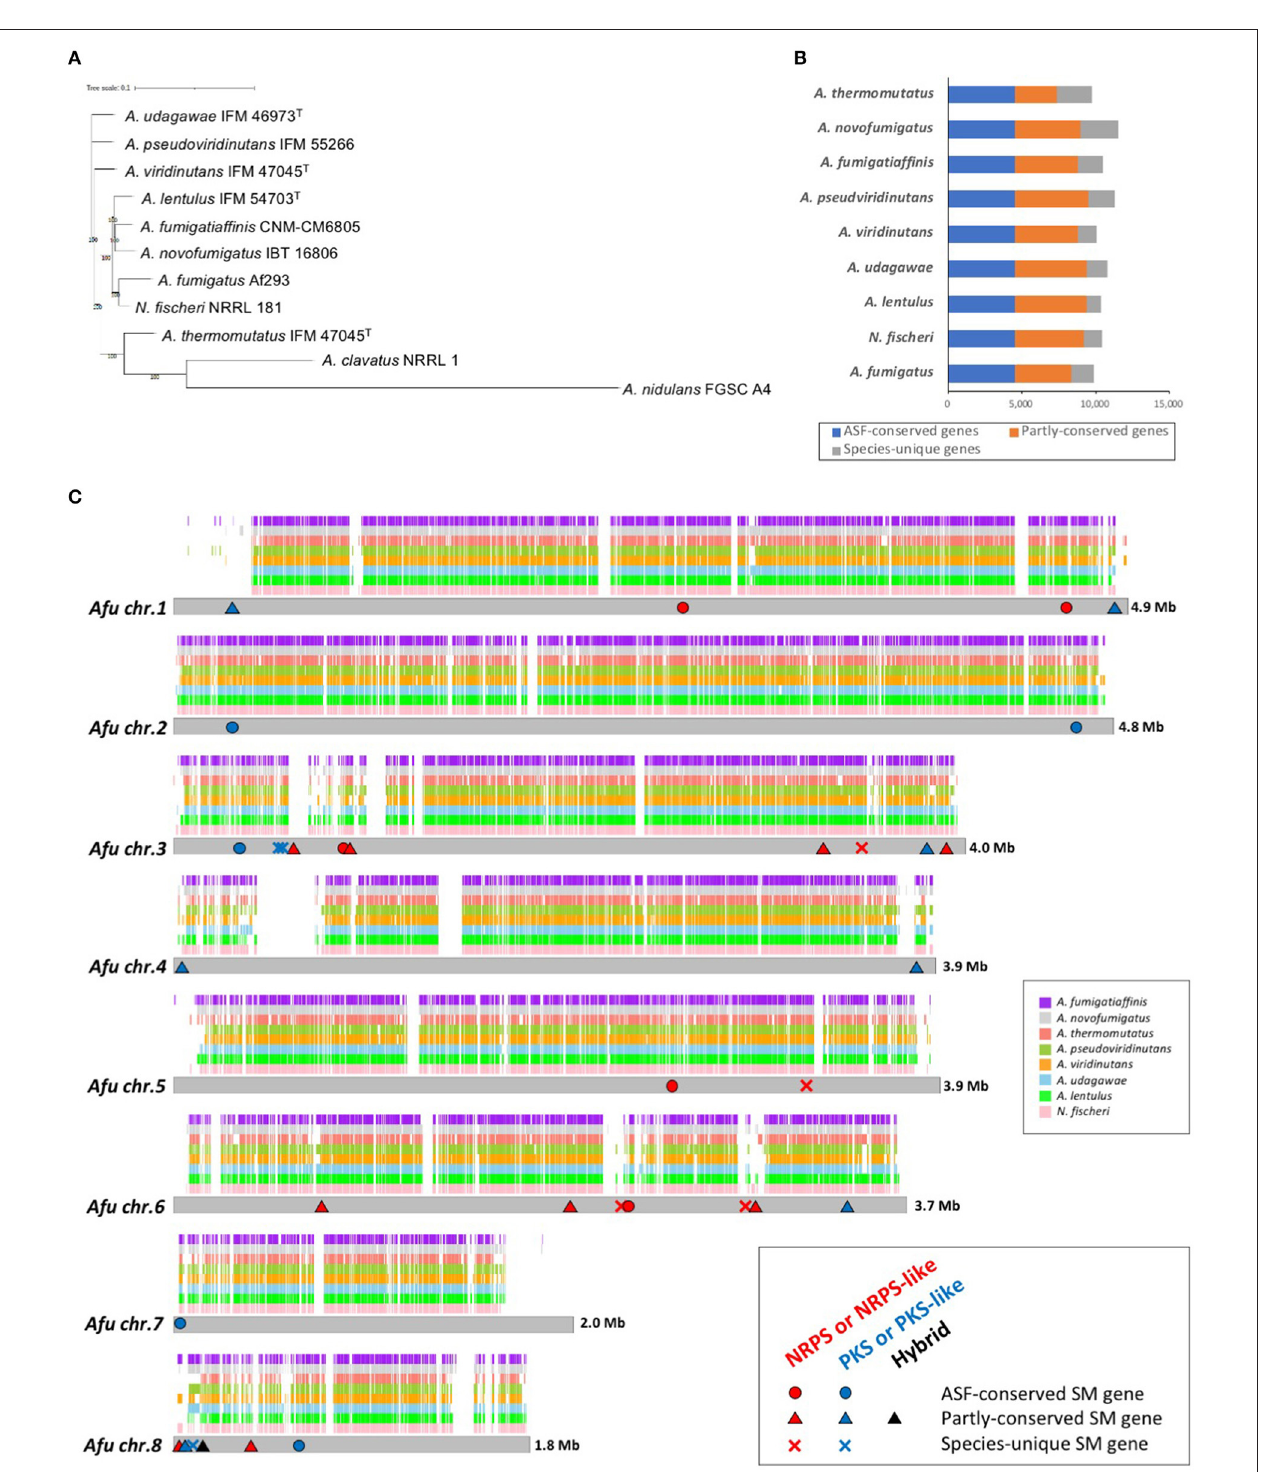
FIGURE 1 | Genome characteristics of Aspergillus section Fumigati strains. (A) Phylogenetic tree of the nine species of Aspergillus section Fumigati used here in addition to A. clavatus and A. nidulans as the outgroup. The tree was constructed using iTOL. (B) The numbers of genes that are conserved across the section (“ASF-conserved genes”), partly conserved, or species-unique are shown. (C) Whole-genome synteny plot based on A. fumigatus chromosomes. The syntenic genes are mapped to A. fumigatus chromosomes. The positions of the ASF-conserved, partly-conserved, and species-unique SM backbone genes of A. fumigatus are indicated with circles, triangles, and crosses, respectively. Genes encoding non-ribosomal peptide synthetase (NRPS) or NRPS-like proteins are colored red, polyketide synthase (PKS) or PKS-like proteins in blue, and PKS-NRPS hybrid proteins in black.